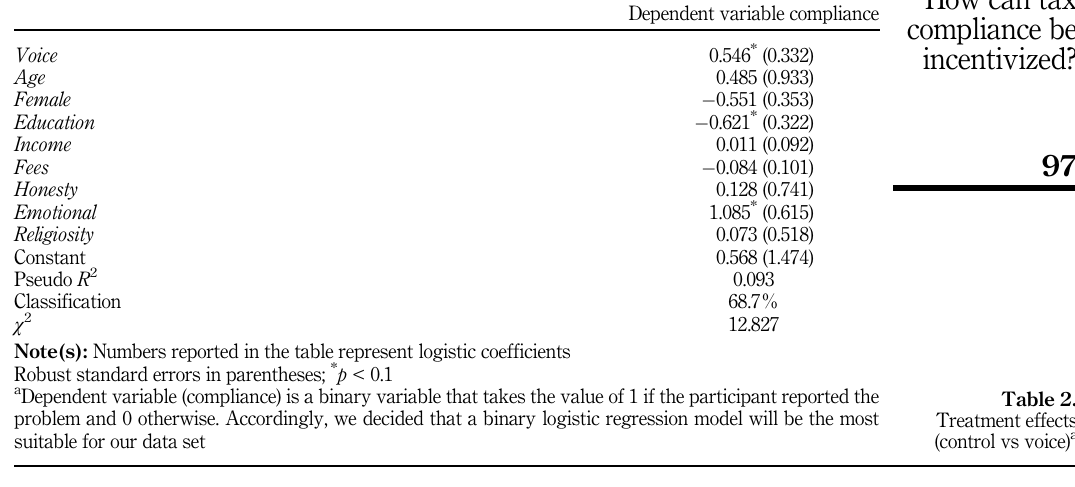
Table 2. Treatment effects